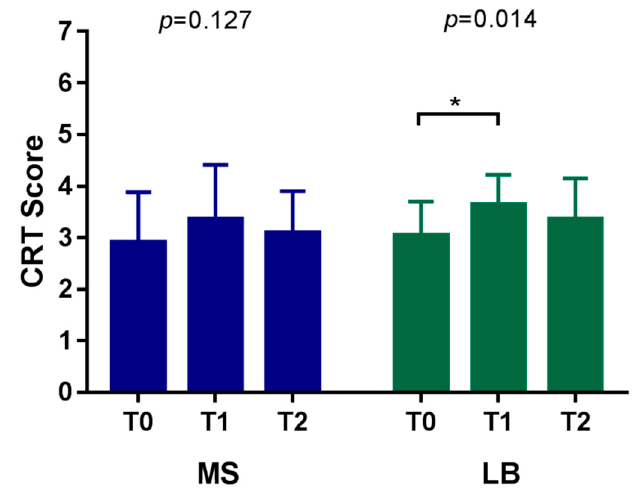
Figure 3. CRT score of the high caries risk group among three time points. Multiple comparison test. * p < 0.05.